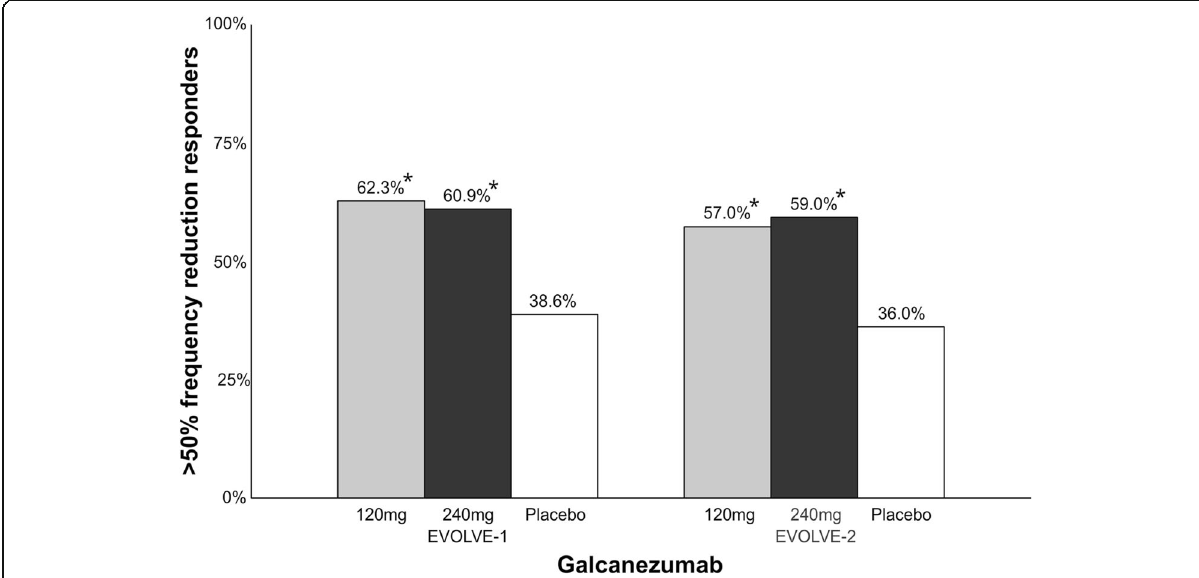
Fig. 10 Overview of patients (%) achieving > 50% reduction in migraine days in phase III clinical trials with galcanezumab. A darker bar indicates a higher dose. *EVOLVE-1; 120 mg vs. placebo, p < 0.001; 240 mg vs. placebo, p < 0.001. EVOLVE-2; 120 mg vs. placebo, p < 0.001; 240 mg vs. placebo, p <